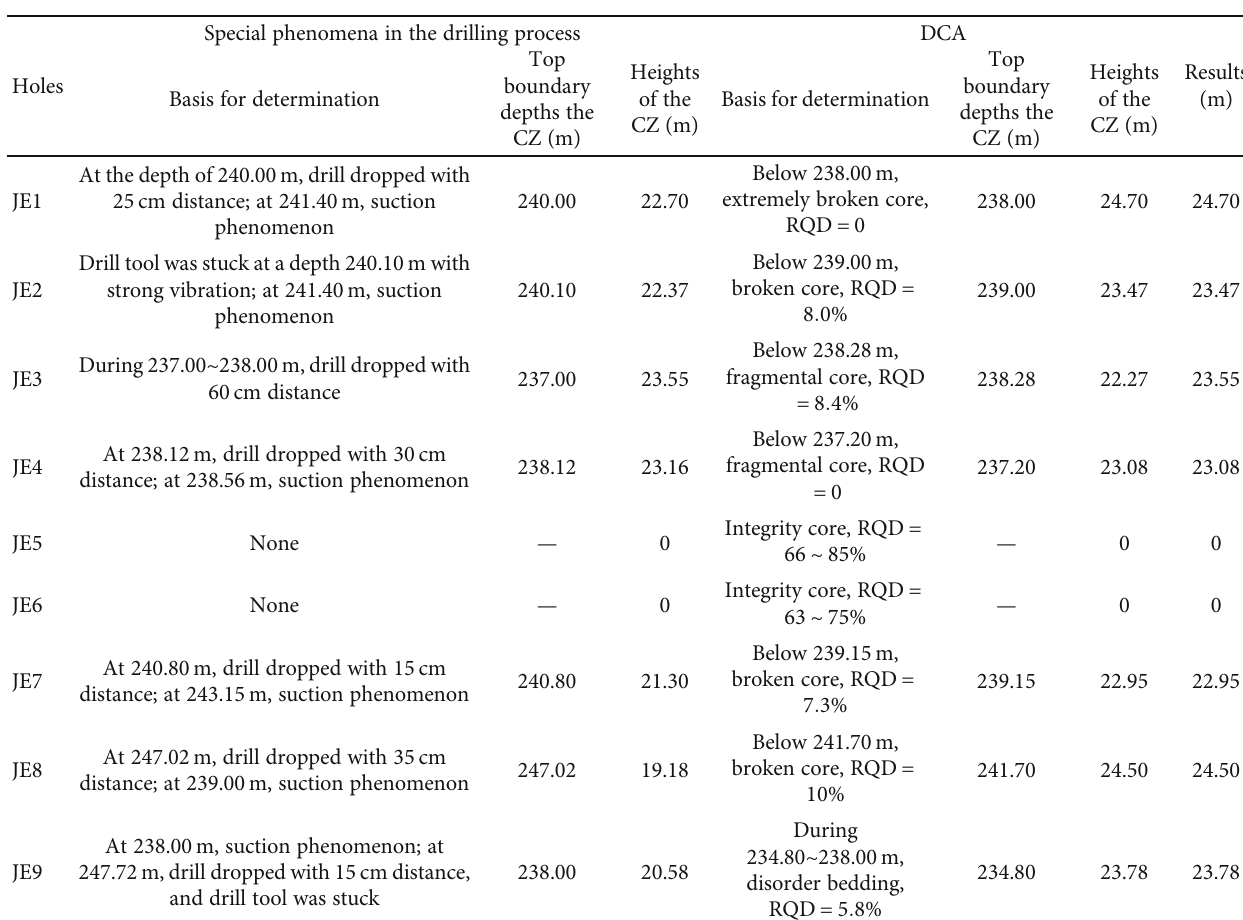
Table 3: Top boundary depths and heights of the CZ in